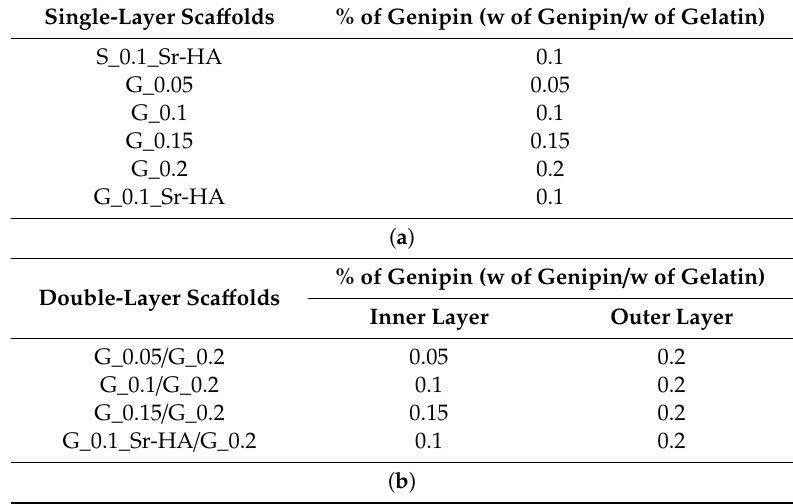
Table 1. Composition of the obtained ( a ) single-layer and ( b ) double-layer scaffolds.